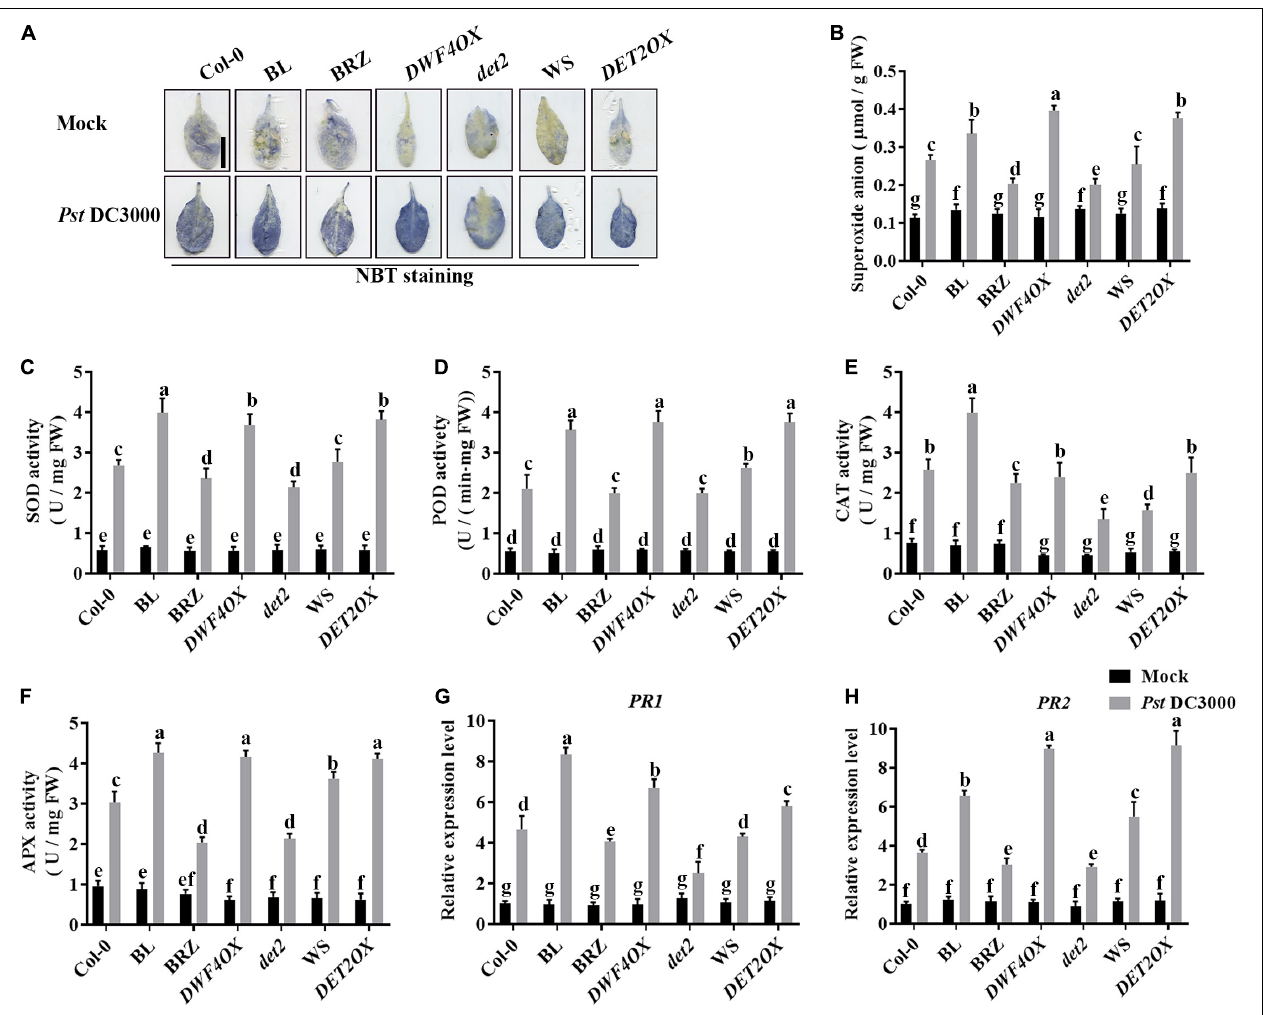
FIGURE 3 | Antioxidant system induced by BRs after infection. (A) Nitroblue tetrazolium (NBT) staining for observing superoxide accumulation at 1 dpi. (B) The superoxide content in the infected leaves at 1 dpi. Bar, 1.00 cm. The activities of the antioxidant enzymes superoxide dismutase (SOD) (C) , peroxidase (POD) (D) , catalase (CAT) (E) , and ascorbate peroxidase (APX) (F) . Bars represent mean ± SD obtained from three biological replicates per genotype and time point, superoxide content or the activities of the antioxidant enzymes measured from five leaves of each genotype and treatment were pooled for one replicate. (G,H) Relative expression levels of defense-related genes PR1 and PR2. The expression of ACTIN2 was used as an internal reference. Data presented are mean ± SD from three independent experiments. Significant differences ( P < 0.05) are denoted by different lowercase letters.